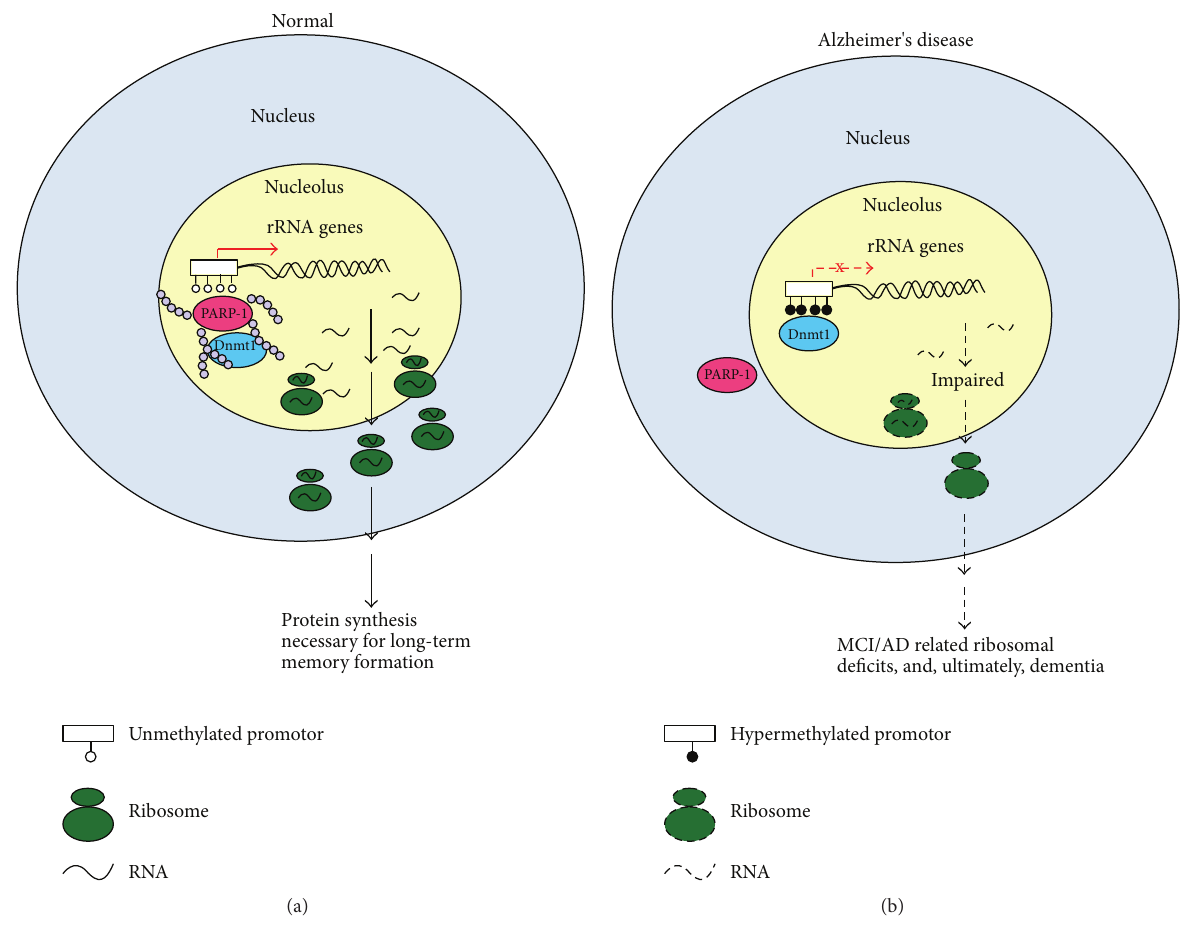
Figure 4: Model. Ribosome biogenesis in Alzheimer’s disease. (a) Normal neuron. PARP-1 activity (PAR) prevents rDNA methylation. PAR = poly(ADPribosyl)ation. (b) AD neuron. Absence of PARP-1 in nucleoli allows DNA methyltransferase (Dnmt1) to methylate rDNA promoters silencing rRNA transcription resulting in nucleolar